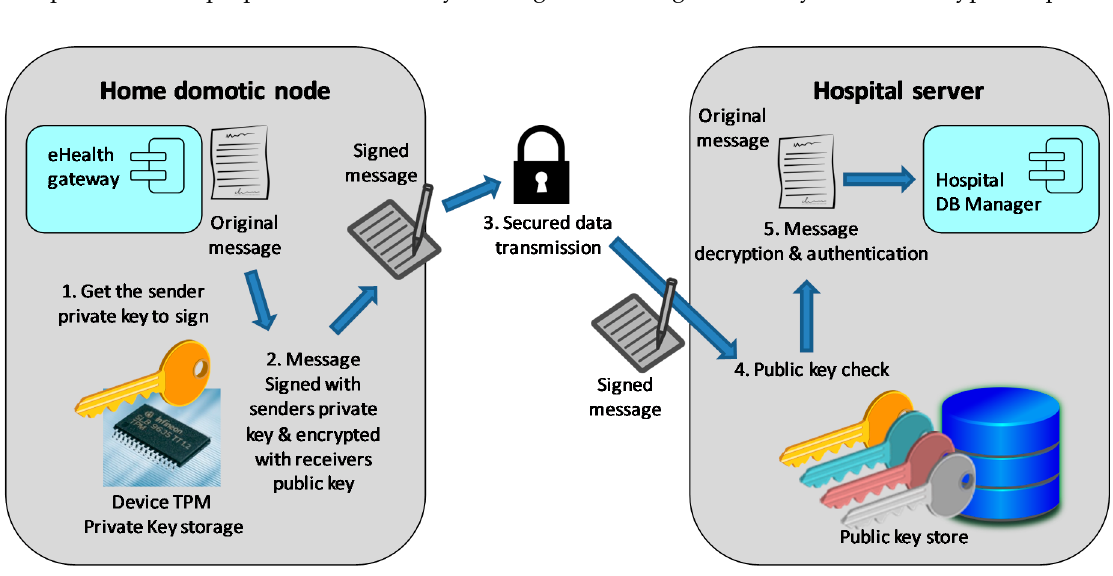
Figure 10 . Data encryption and device authentication process. Figure 10. Data encryption and device authentication